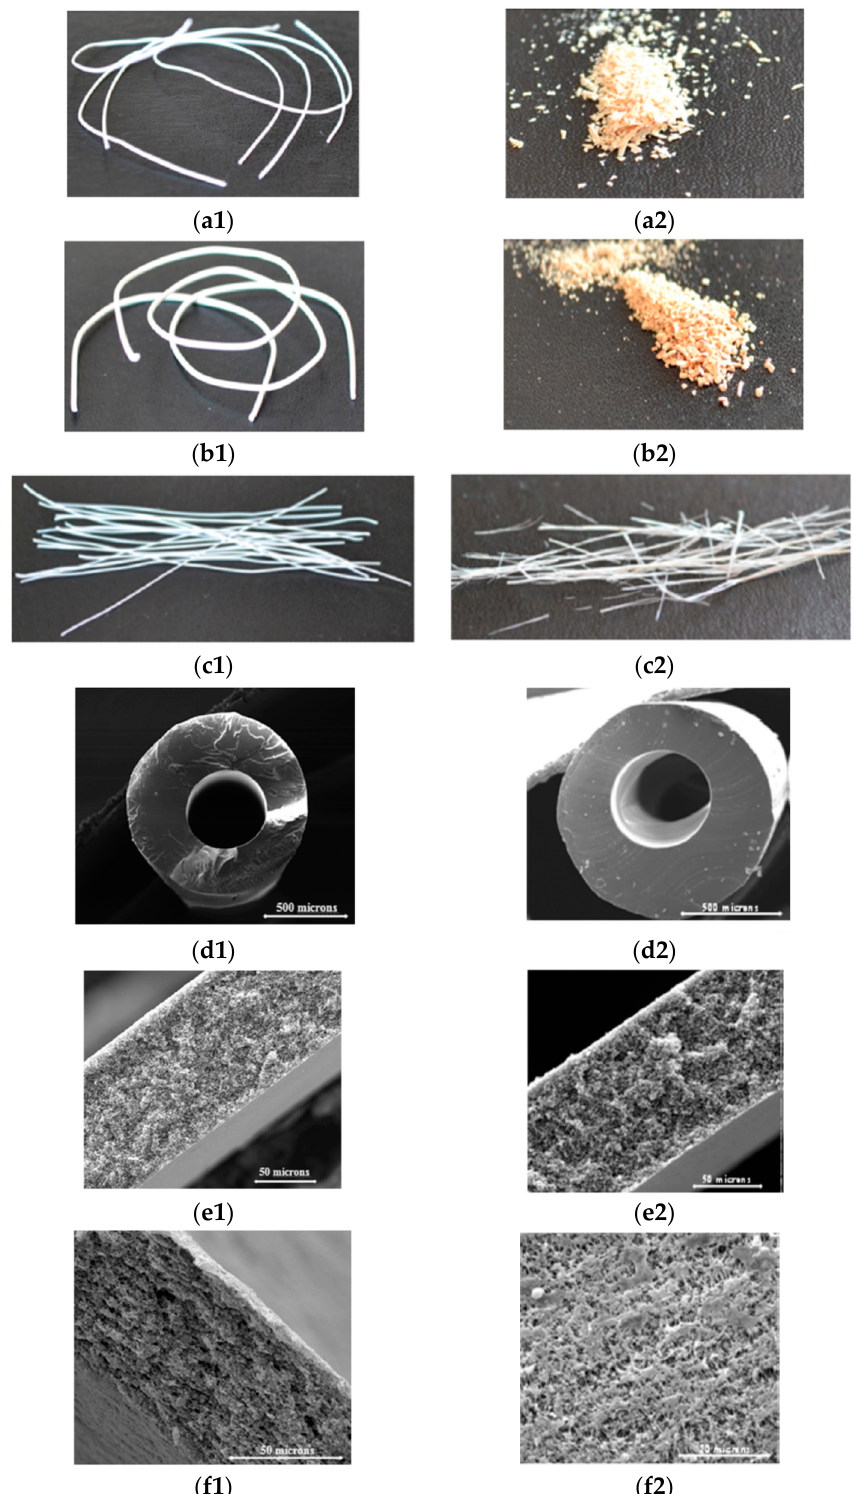
Figure 3. Simple and SEM microphotographs of commercial polymeric membranes before: PES ( a1 ), PEI ( b1 ), PP ( c1 ), PDMS ( d1 ), PVDF ( e1 ) and PTFE ( f1 ), and after the application of 4 h of ozonation: PES ( a2 ), PEI ( b2 ), PP ( c2 ), PDMS ( d2 ), PVDF ( e2 ) and PTFE ( f2 ) (Adapted from [12]).